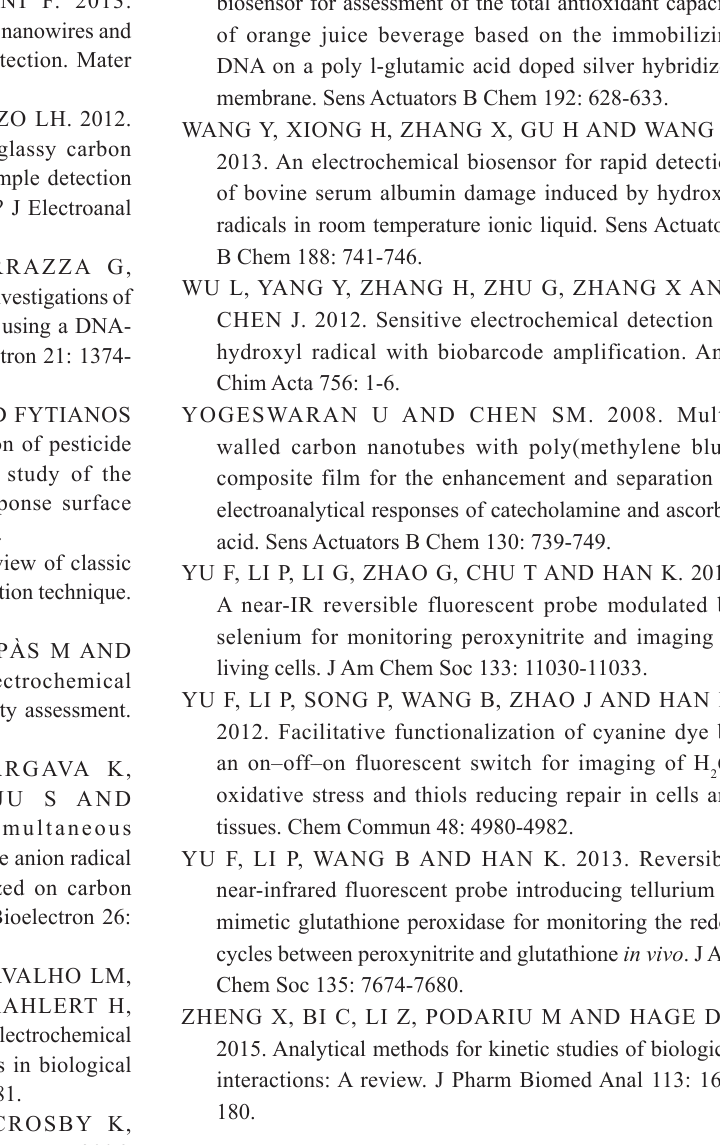
Figure S1 - exponential decay after OH • attack to the PMB- modified electrode in presence and absence of 10 mM ascorbic acid added to the Fenton solution. Error bars are related to triplicate